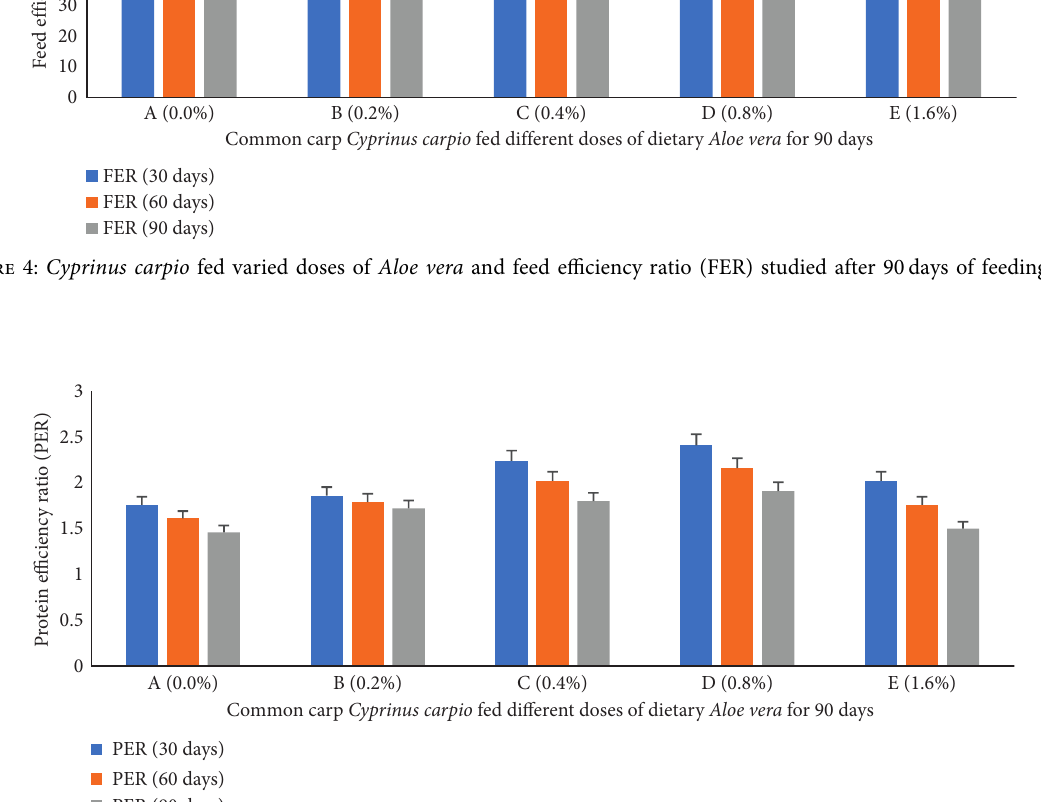
Figure 5: Cyprinus carpio fed varied doses of Aloe vera and protein efficiency ratio (PER) studied after 90 days of feeding trial.